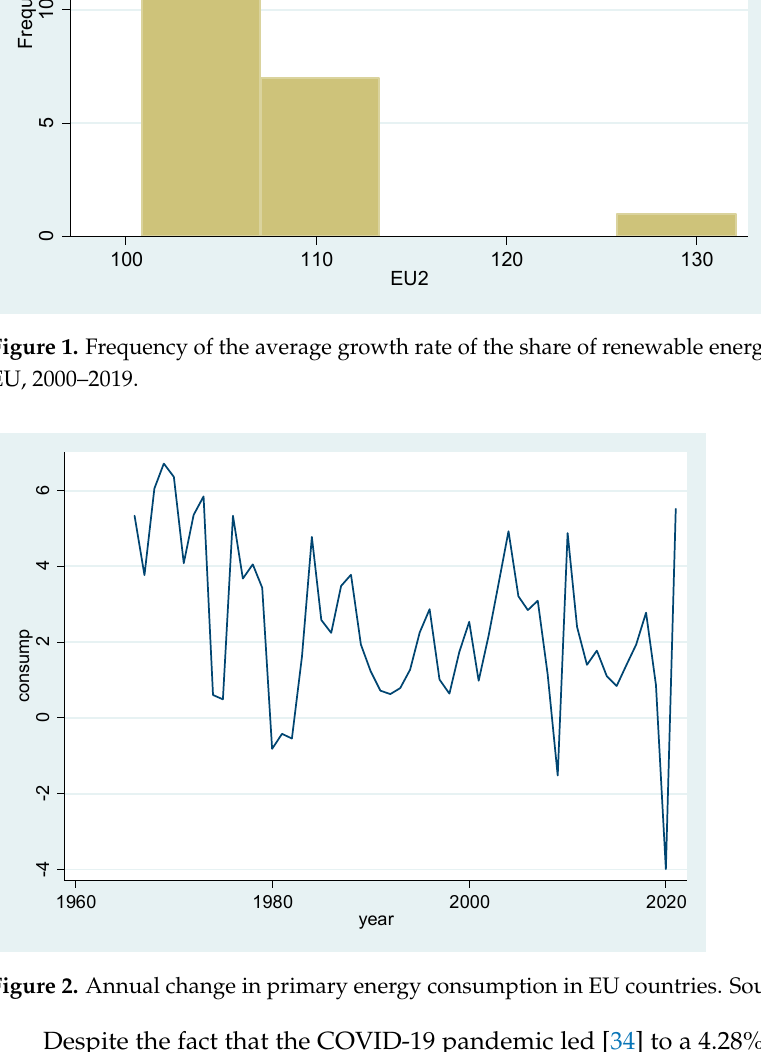
Figure 2. Annual change in primary energy consumption in EU countries. Source: [33].